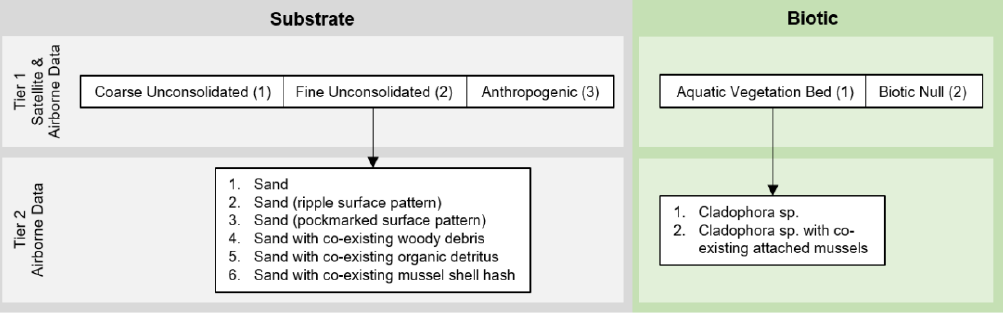
Figure 6. Tiered CMECS class short names and class values (class tier index numbers).